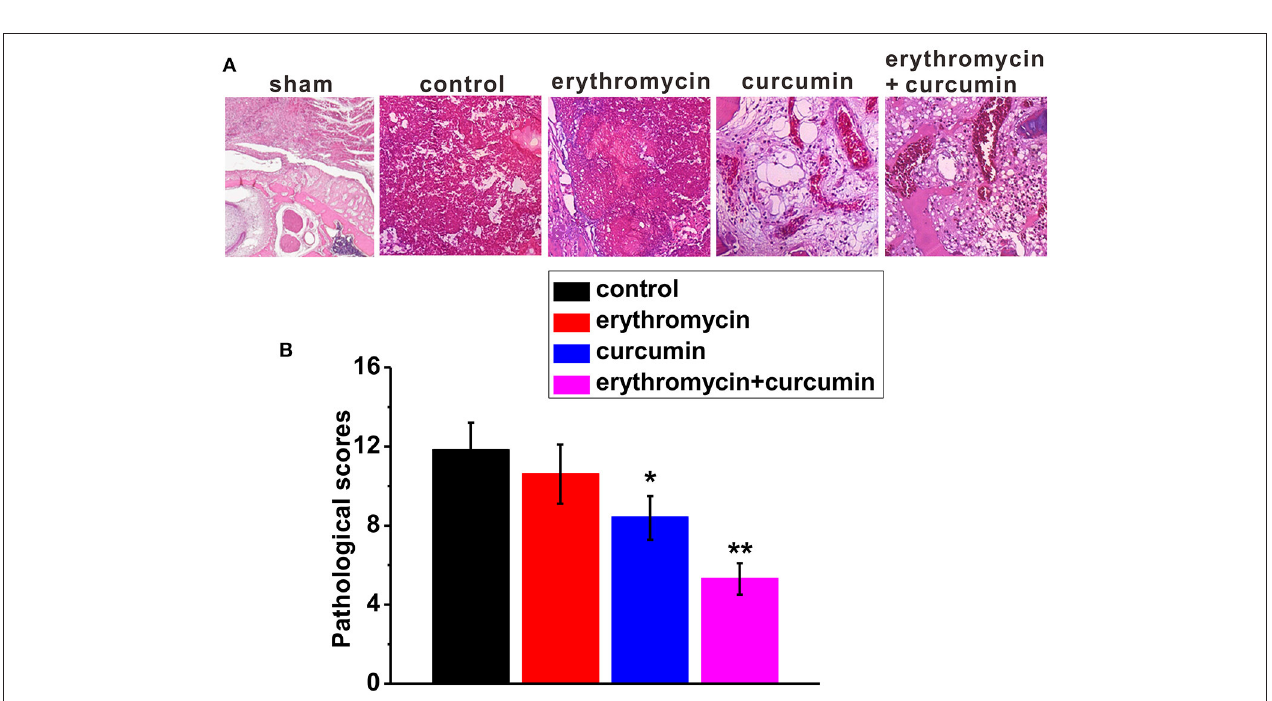
FIGURE 3 | Histological examination in the tibiae of experimental rats. Representative images of H&E staining (A) and histological scores (B) in each experimental group. Note that the representative image of sham was from a healthy bone. Results were presented as mean ± SD * p < 0.05 and ** p < 0.01 vs.